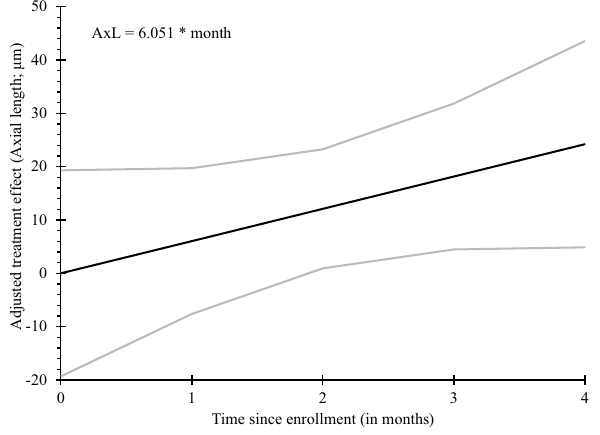
Figure 4. Cumulative adjusted treatment effect based on axial length (microns). Light grey lines represent the 95% confidence band around the regression line.